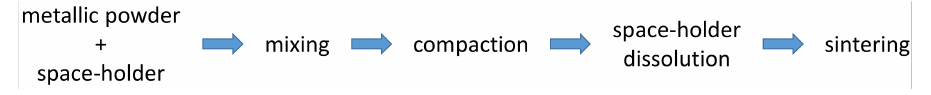
Figure 1. The main steps of the space-holder fabrication